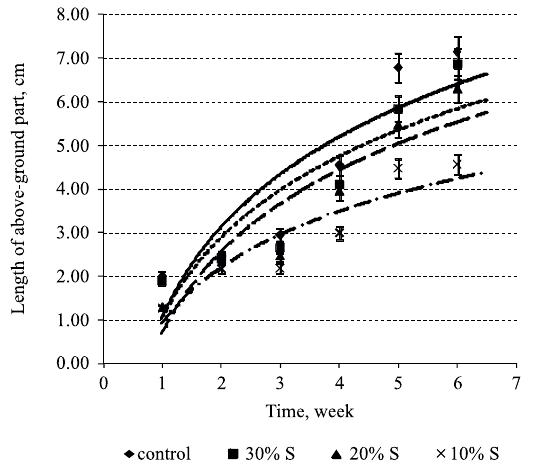
Fig. 11. Length variation of above-ground part of white clover